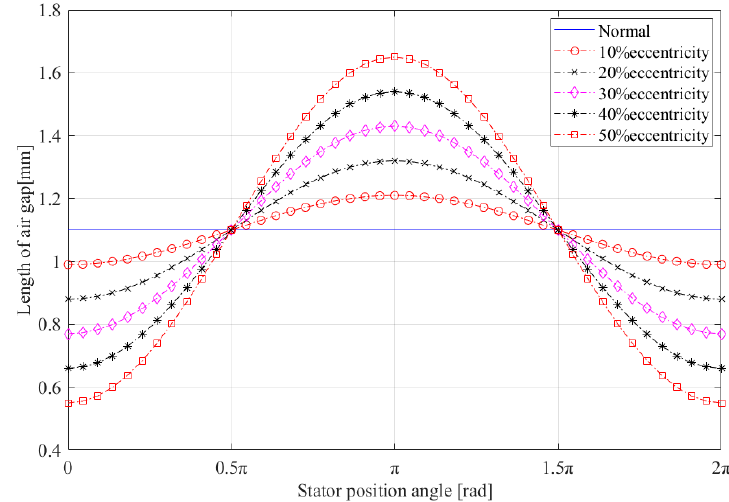
Figure 2. Variation of the air-gap length under static eccentricity. As can be seen in Figure 2, when the rotor is static eccentricity, in the (0, 0.5 π ) and (1.5 π , 2 π ) regions, the air-gap length is less than that of the motor in normal operation, which makes the air-gap permeability greater than that of the motor during normal oper- ation at these locations, and the same magnetic potential produces a greater magnetic density. As the eccentricity increases, the range of air-gap length variation also increases with it. When the eccentricity is 50%, the maximum air-gap length can reach 1.65 mm. The degree of eccentricity is defined as follows: